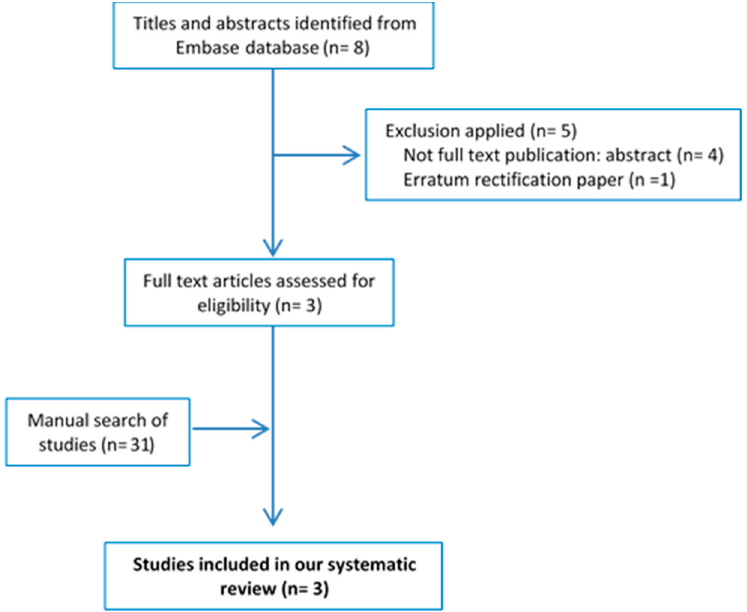
Figure 1. Flowchart for the systematic review.